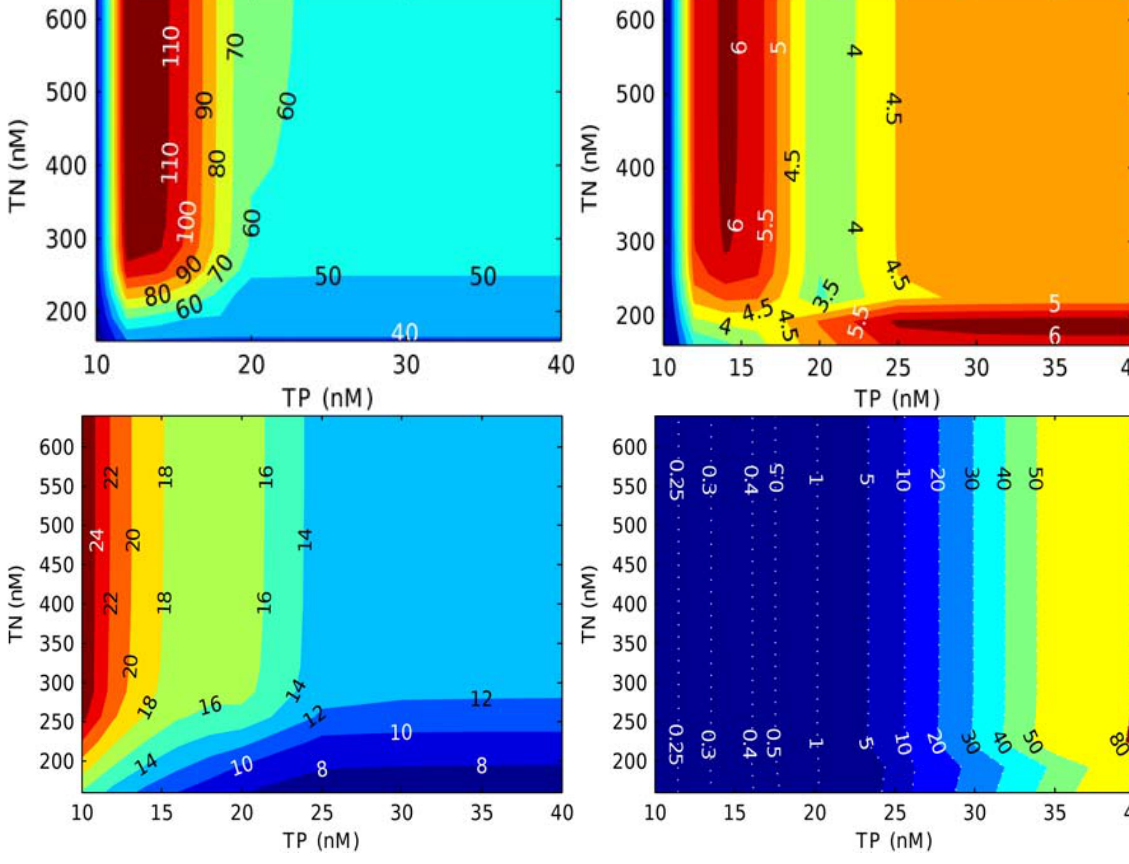
Fig. 5. Inorganic N (a) and P (b) uptake rate (nmoll − 1 d − 1 ), (c) N to P ratio of nutrient uptake and (d) inorganic phosphate turnover time ( h ) as a function of TN and